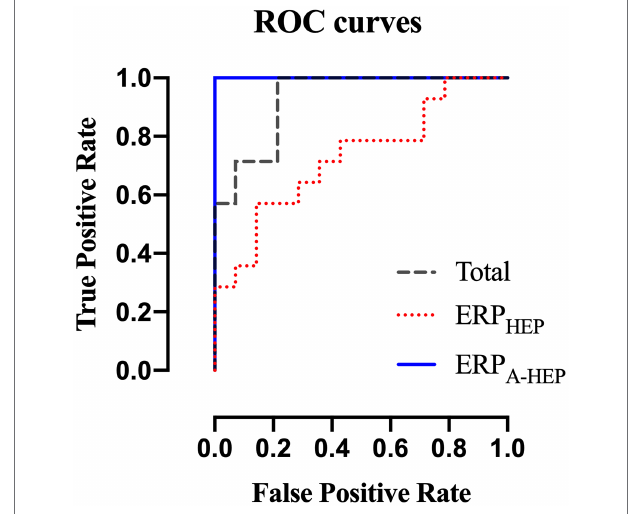
FIGURE 9 | Receiver operating characteristics curves for ERP T , ERP HEP , and ERP A-HEP according to the RBF-SVM